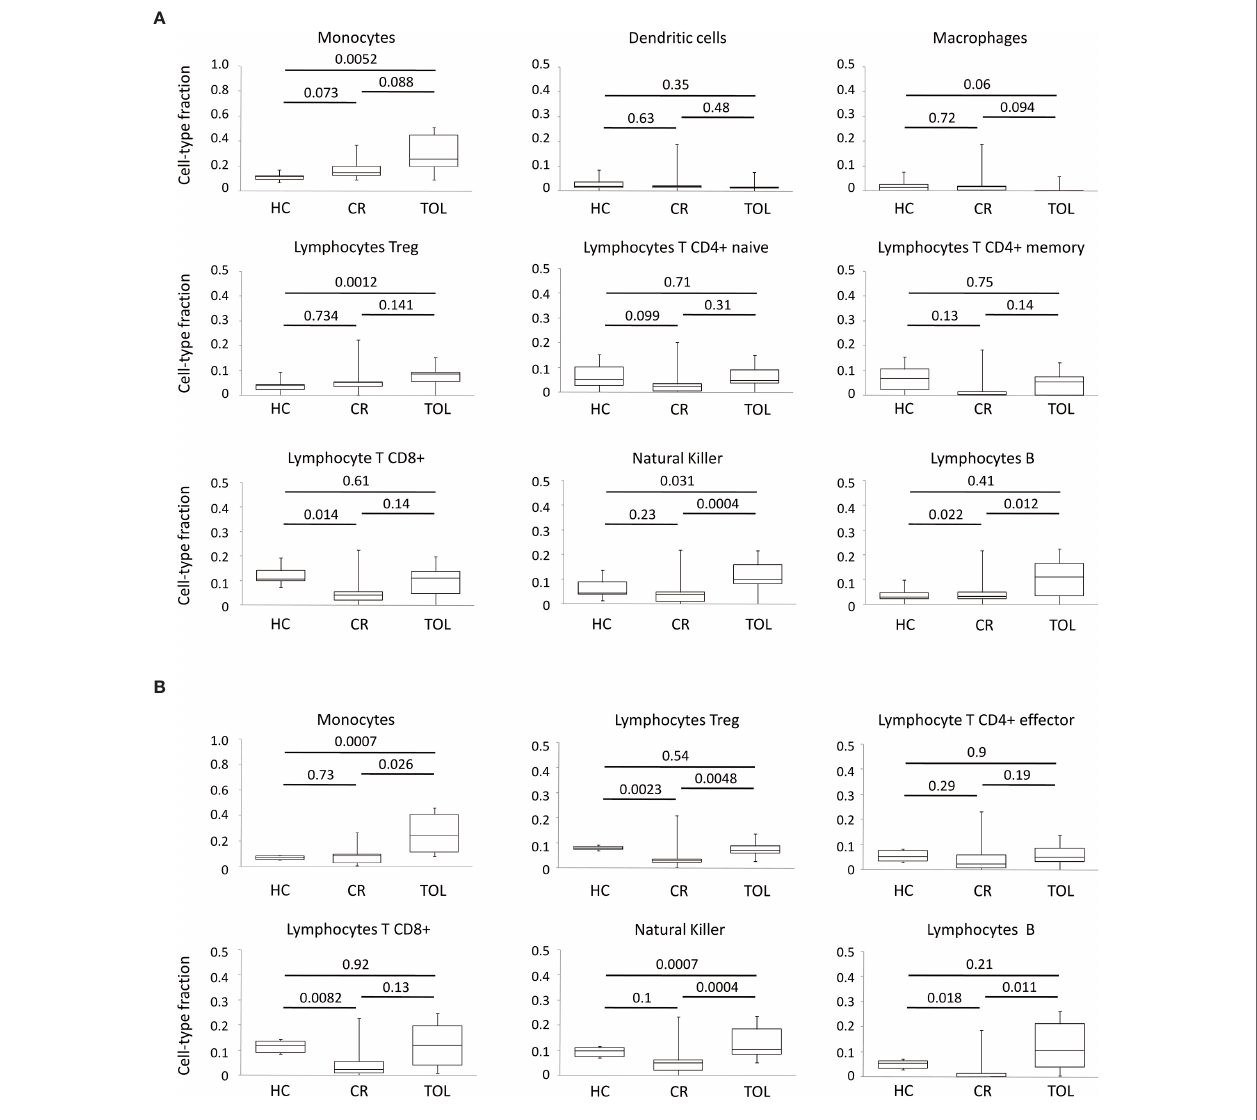
FIGURE 4 | Deconvolution analysis of DNA methylation data in KTR. (A) Boxplots for cellular deconvolution by MethylResolver. (B) Boxplots for cellular deconvolution by MethylCIBERSORT. P-values for Wilcoxon ’ s Rank Sum Tests are